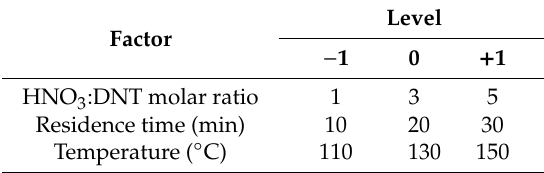
Table 5. Limit levels of and central points of the three factors considered in the experimental design.